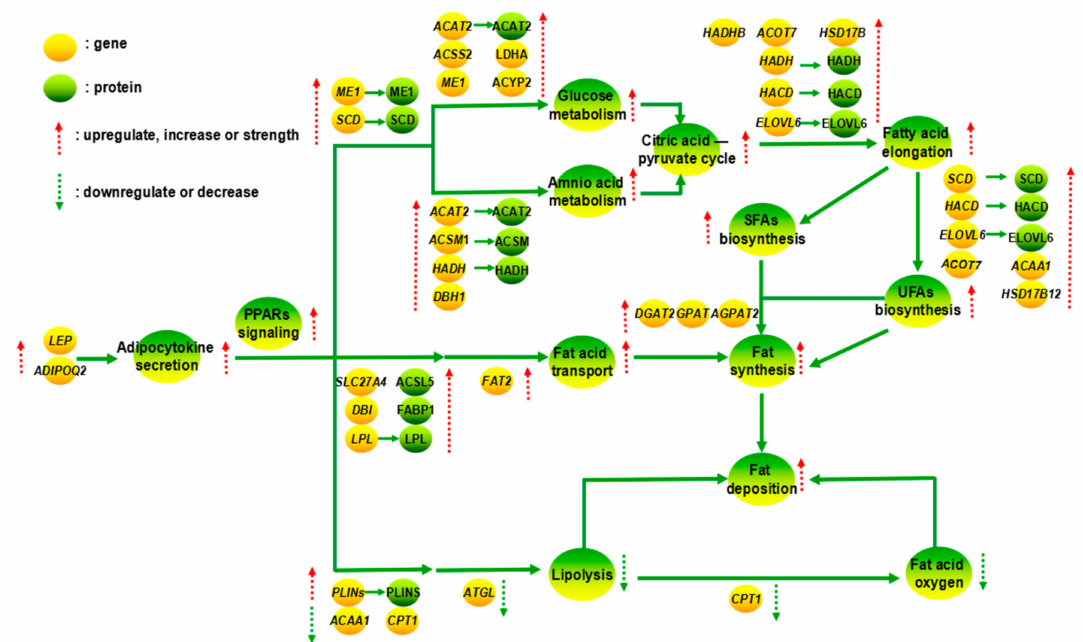
Figure 4. The effect of different gender to fat metabolism in yaks by PPAR signaling